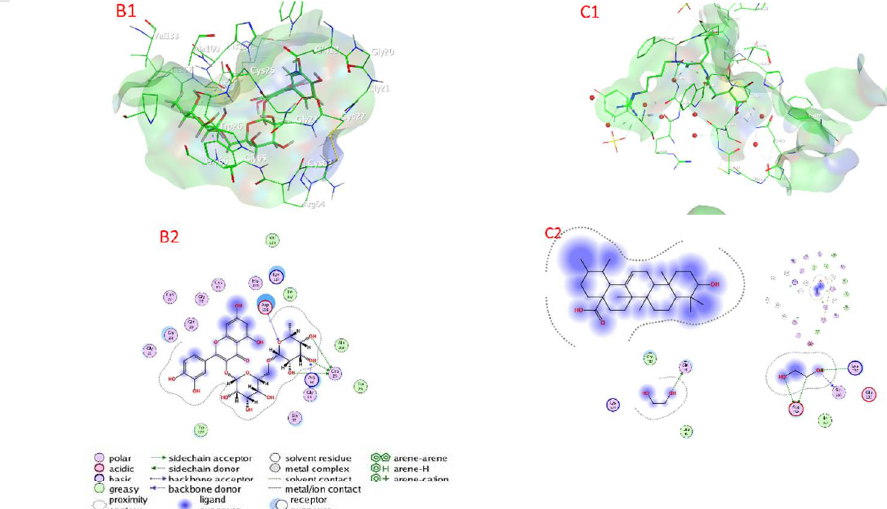
Figure 6. Docking view of ( A1 , A2 ) rosmarinic acid glucoside, ( B1 , B2 ) quercetin-3-O-rutinoside, and ( C1 , C2 ) ursolic acid in the binding sites of cysteine protease (PDB:3IOQ); ( A1 , B1 , C1 ) 3D complex structures (stereoview), and ( A2 , B2 , C2 ) 2D interaction diagram structures.